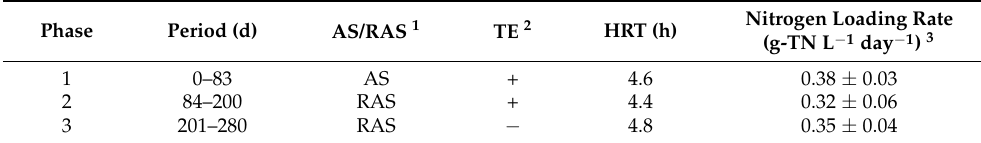
Figure 2. Schematic drawing of the up-flow column reactor. Table 3. Operational conditions of the column